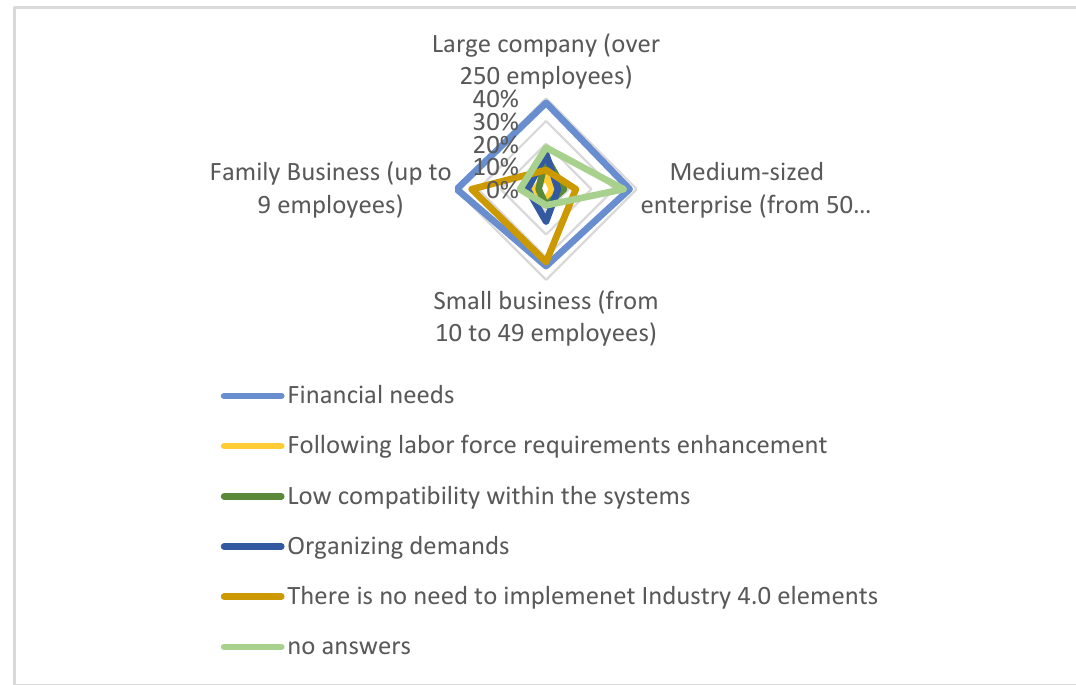
Figure 6. Reasons not to implement the Industry 4.0 concept in enterprises by size of enterprise.